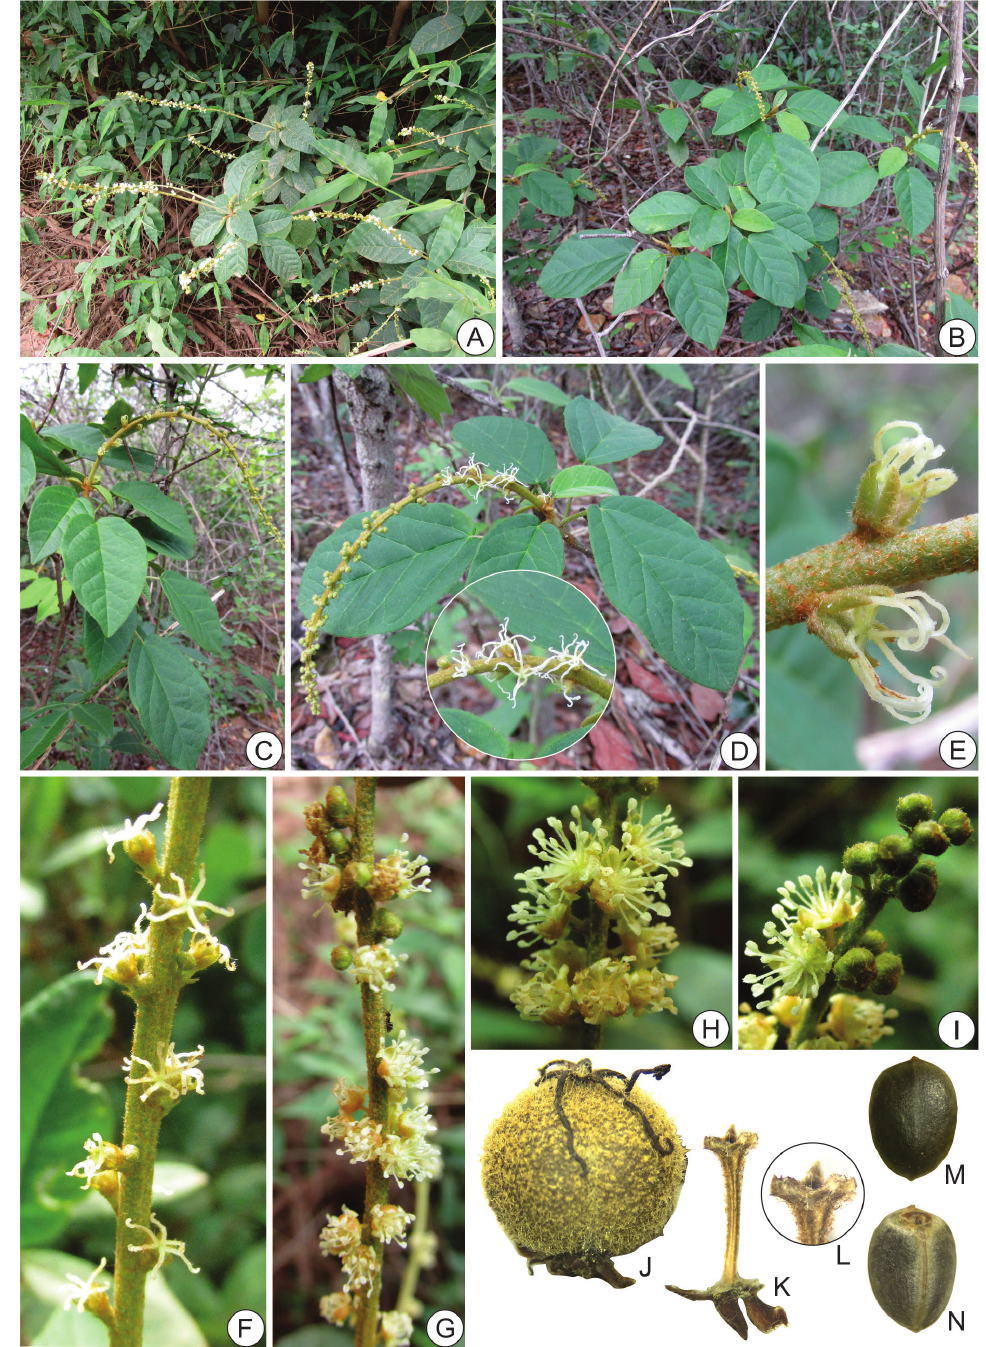
Fig. 5. Croton echioides Baill. A–B . Habit. C . Flowering branch. D . Inflorescence showing pistillate flowers and staminate buds, detail of the pistillate flowers in the insert. E . Pistillate flowers. F . Median portion of an inflorescence with bisexual cymules containing one pistillate flower and one staminate bud. G . Detail of the staminate inflorescence. H . Staminate flowers. I . Staminate flowers and buds. J . Fruit. K . Fruit columella. L . Apex of columella with three slightly ascending tips. M . Seed, dorsal side. N . Seed, ventral side. A, F–I. = Population from Igaporã, Bahia ( R.C. Sodré et al. 3284 ; BOTU); B–E. = Population from Abaíra, Bahia ( R.C. Sodré et al. 3314 ; BOTU); J–N. = V.C. Souza et al. 5495 (ESA). Photographs: R.C.